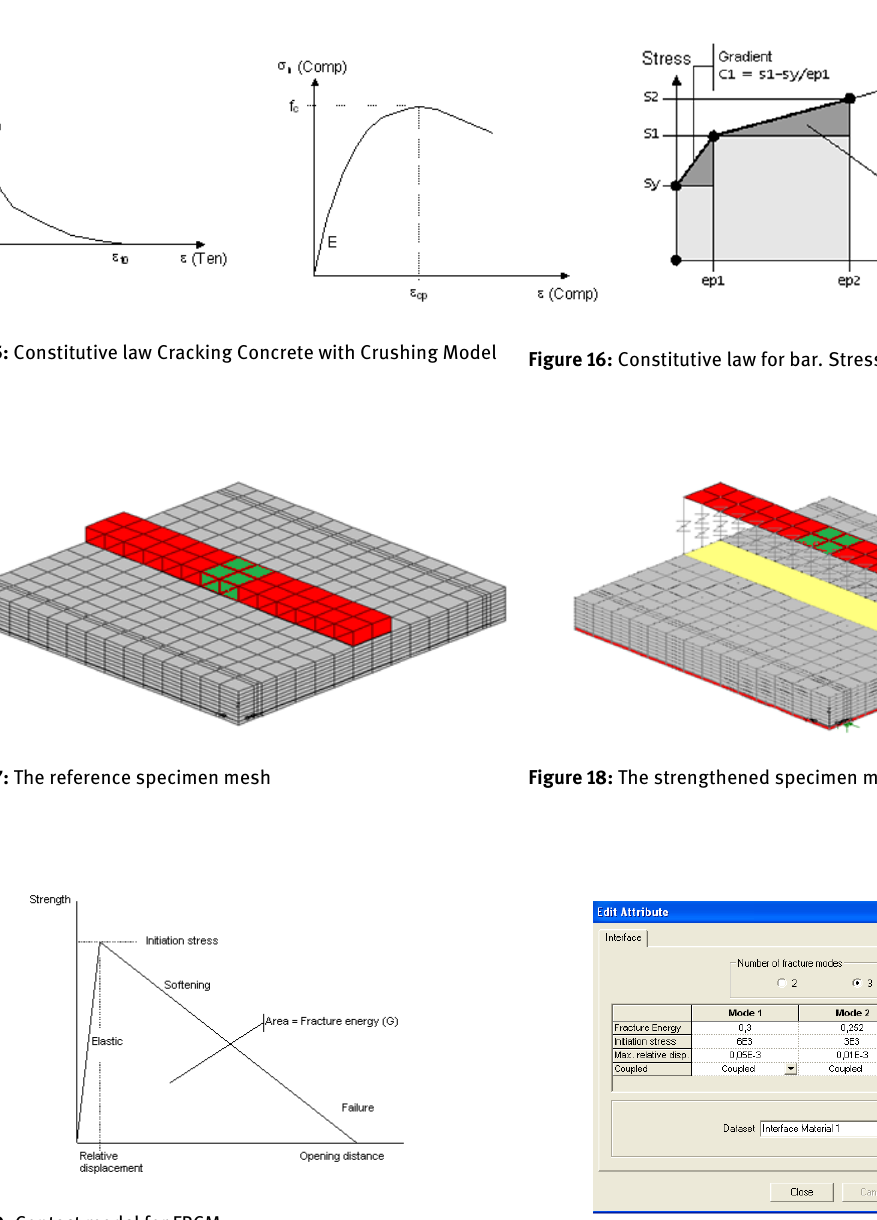
Figure 19: Contact model for FRCM